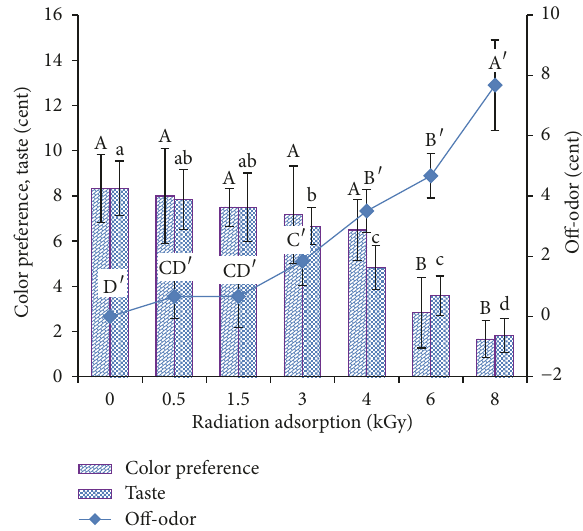
Figure 4: Effect of irradiation on sensory attributes of SBJ. Values are represented as mean ± SD. Significance was tested by Duncan Multiple Range Test at 𝑃 < 0.05 , and values with the same superscript were found not significantly different from each